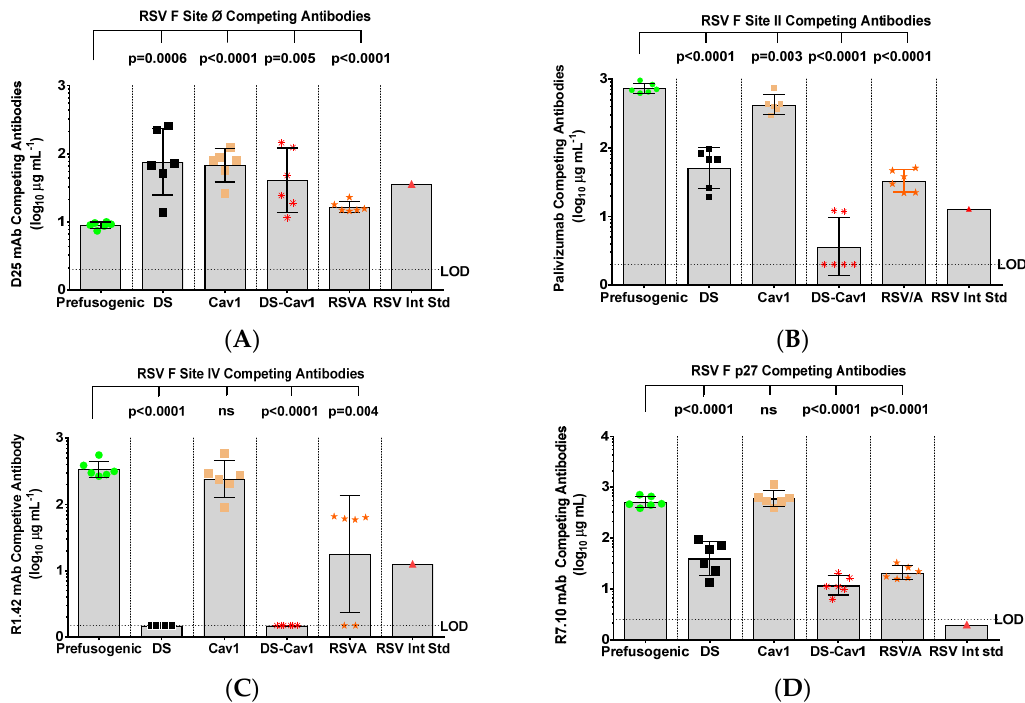
Figure 6. Specificity of antibodies elicited by prefusogenic F compared to prefusion F variants in cotton rats. Female cotton rats were immunized with 1.0 µg RSV F proteins with 30 µg aluminum phosphate and a control group was challenged intranasally with RSV/A Long. Cotton rats were immunized and serum analyzed 21 days after the second immunization, as described in Figure 4. The specificity of the humoral response was determined by a competitive antibody binding ELISA using site-specific mAbs: ( A ) D25 (site Ø), ( B ) palivizumab (site II), ( C ) R1.42 (site IV), and ( D ) R7.10 (p27). Individual animal values are indicated by colored symbols for each immunization group. The bars indicate the group (N = 6 per group) geometric mean titer (GMT) and the error bars indicate the ± 95% CI. Statistical significance between the RSV prefusogenic F group (BV1184) and the paired groups is indicated. World Health Organization (WHO) RSV International Standard (RSV Int Std). Limit of detection (LOD). Not significant (ns).